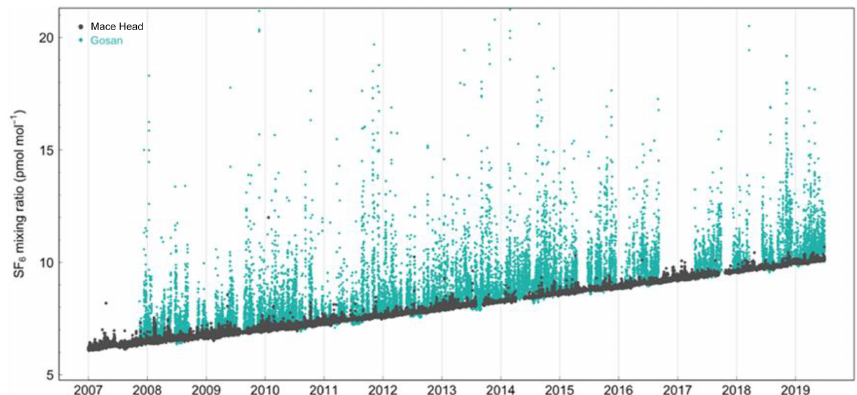
Figure 3. Atmospheric mixing ratios (pmol mol − 1 ) recorded at Mace Head, Ireland (black), printed on top of the Gosan mixing ratios, Jeju Island, South Korea (green). Elevated mixing ratios represent pollution events associated with regional emissions. GSN occasionally shows a Southern Hemisphere (SH) influence during the summer, which accounts for the cases in which GSN plots below MHD.